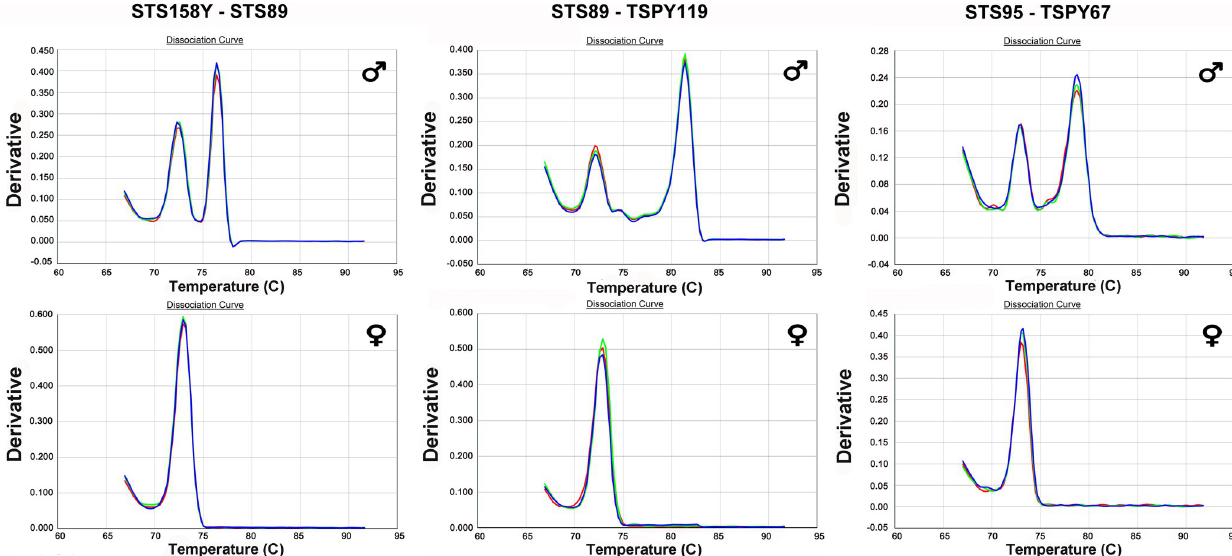
Fig 3. Thermal denaturation curves of amplification products in qPCR-duplex on modern DNA. Amplification products were obtained using 400 pg male ( ♂ ) and female ( ♀ ) DNA as a template in a 20 μ l reaction system. The pairs of primers used were: STS158Y/STS89 showing two amplification products, having Tm of 72.2˚C and 76.5˚C, and a single amplification product, having a Tm of 72.4˚C, using male and female DNA respectively; STS89/TSPY119 showing two amplification products, having Tm of 72.7˚C and 81.5˚C, and a single amplification product, having a Tm of 72.7˚C, using male and female DNA respectively; STS95/TSPY67 showing two amplification products, having Tm of 73.5 and 79.2˚C, and a single amplification product, having a Tm of 72.7˚C, using male and female DNA